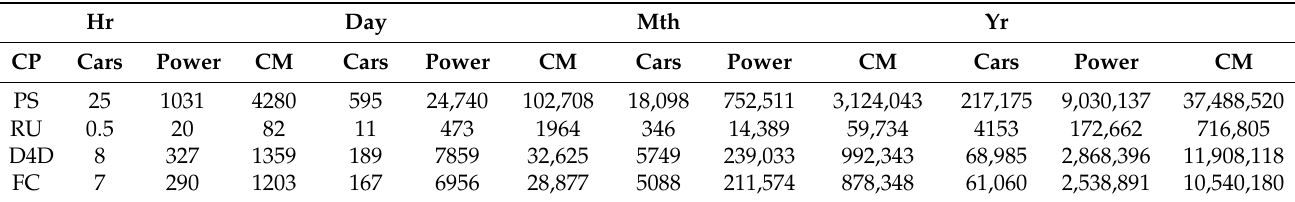
Table 4. The tabulated values of each of the charging profiles. PS, RU, D4D, and FC stand for petrol station, road usage, Drive-4-Data, and fast-charge charging profiles, respectively. The hourly, daily, monthly, and yearly values for the number of cars arriving, energy demand, and the total number of charged miles (CM) have been